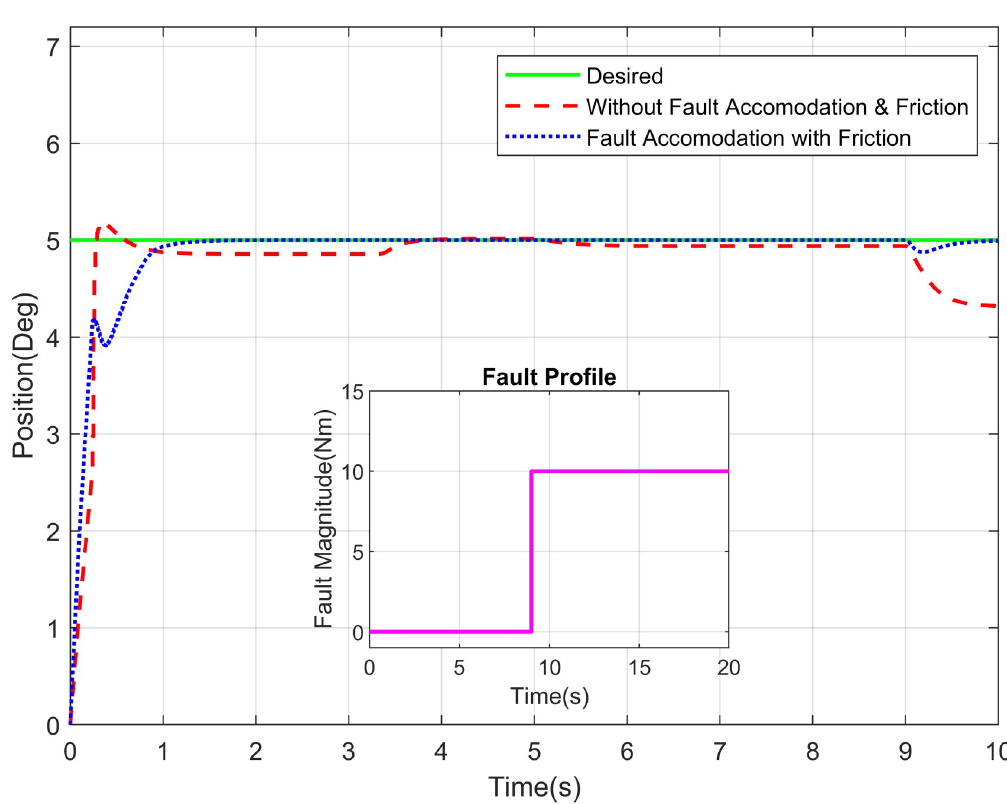
Fig 10. Position tracking of elbow joint of a robot manipulator with abrupt fault profile.